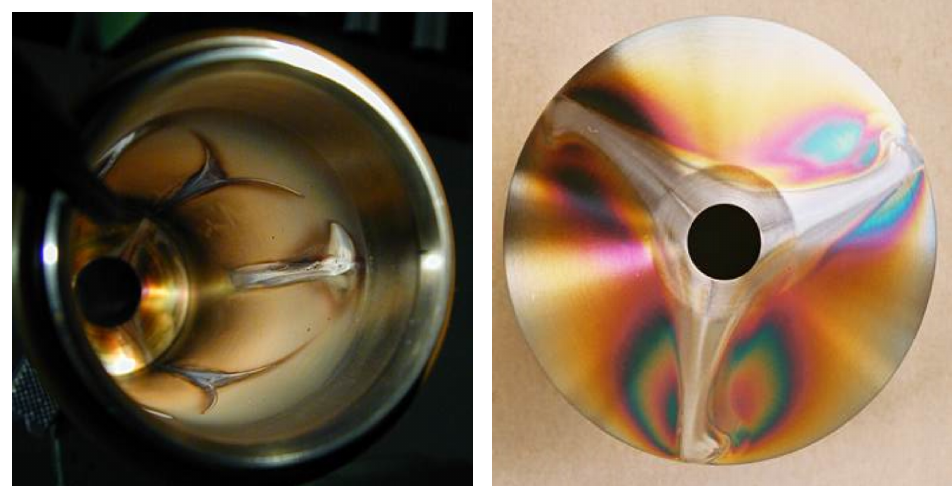
Figure 3. Erosion marks after some operating time. Left: Interior of the PC, showing the six loss lines and the region where the radial component of the hexapole field adds to the stray field of the mirror. Right: plasma electrode (plasma side) with extraction aperture, showing three of six loss lines. Note that these loss lines are generated by plasma